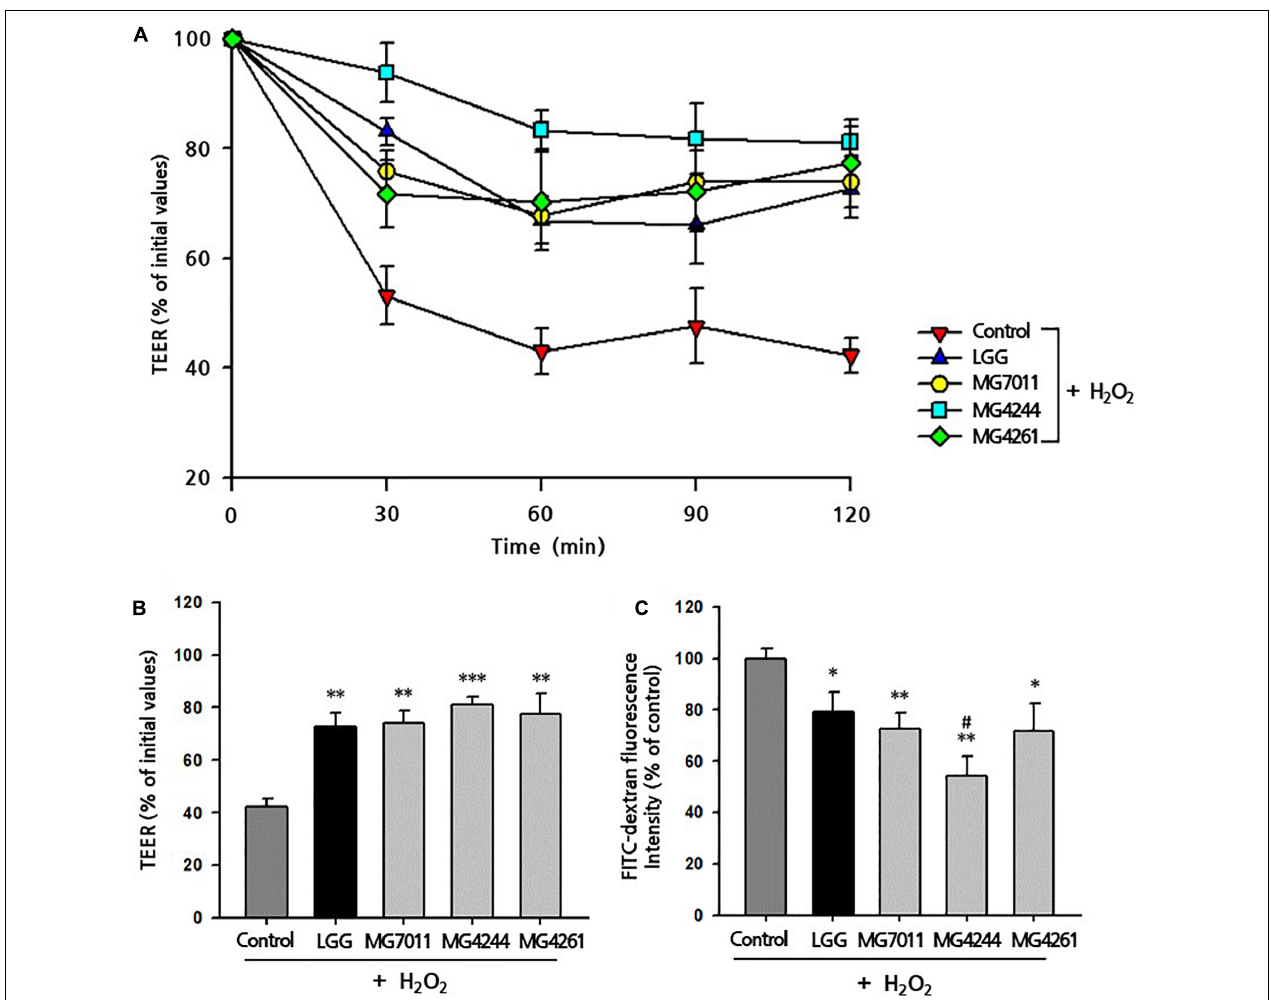
FIGURE 5 | Preventive effect of Limosilactobacillus fermentum strains on H 2 O 2 -induced permeabilization of Caco-2 cell monolayers. Caco-2 cell monolayers were pretreated with bacterial cells for 30 min, and the monolayers were exposed to H 2 O 2 (100 µ M). TEER was measured (A) every 30 min (B) until 2 h after H 2 O 2 treatment. FITC-dextran fluorescence intensity (C) was measured 4 h after TEER measurement and expressed in% compared with control value. Limosilactobacillus rhamnosus GG (LGG) was used as a positive control. All data are expressed as mean ± SD ( n = 3). ∗ p < 0.05, ∗∗ p < 0.01, ∗∗∗ p < 0.001 compared with control and # p < 0.05 compared with